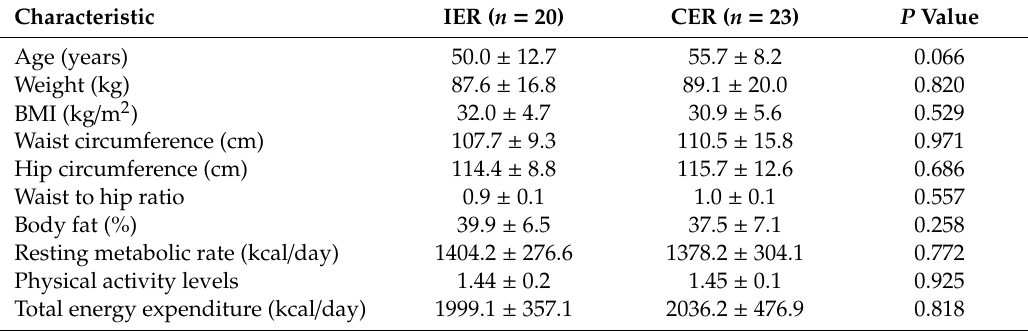
Table 1. Baseline Characteristics. There are no significant di ff erences in baseline characteristics between the intermittent energy restriction (IER) or the continuous energy restriction (CER) group. Data is representative of both genders as a single cohort. Values are presented as mean ± standard deviation.